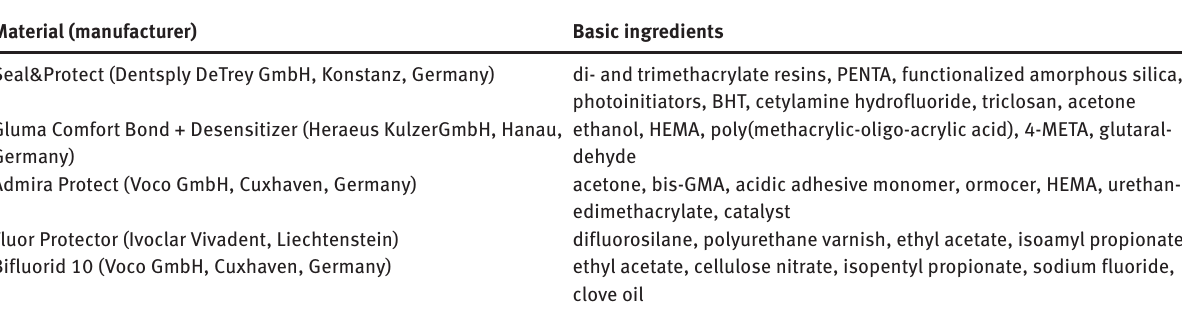
Table 2: Composition of selected commercial dentinal desensitizing agents